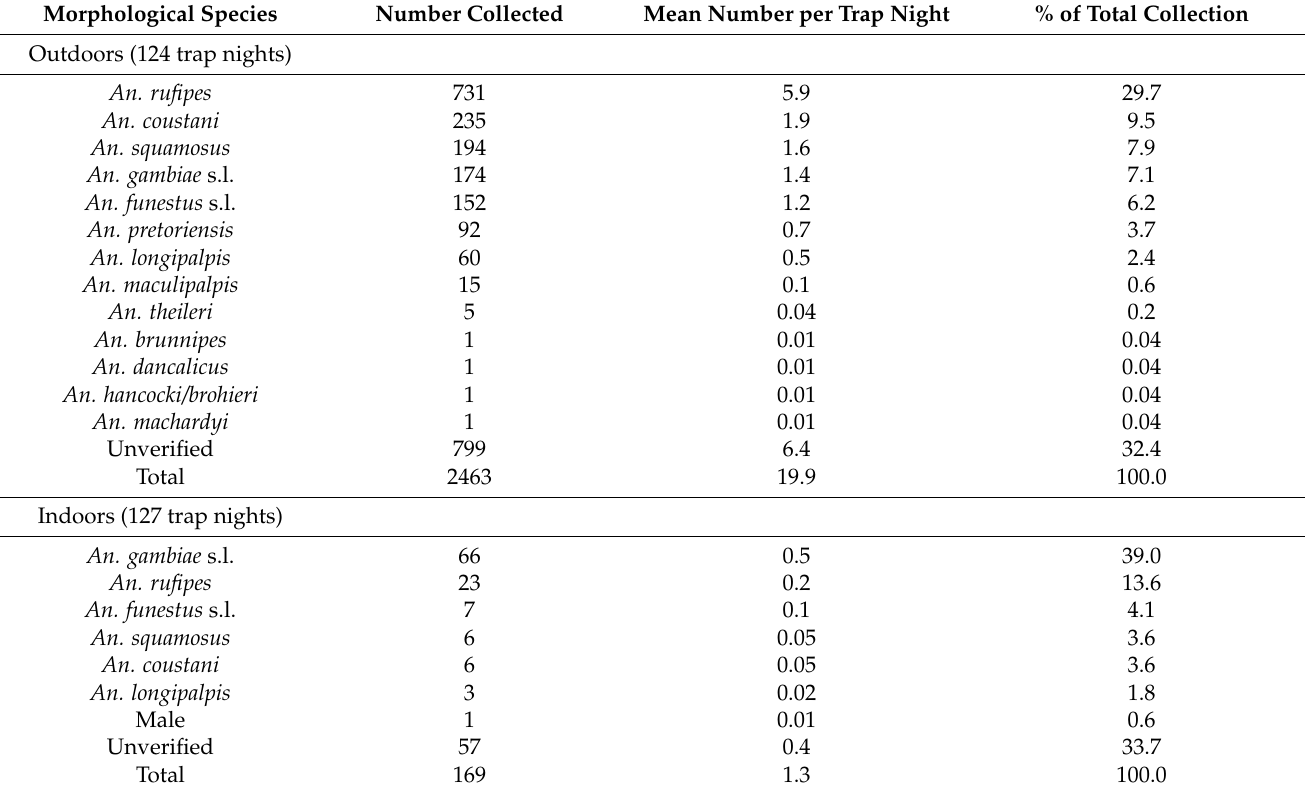
Table 2. Morphological species composition of the transect collections from May 2018–June 2018.